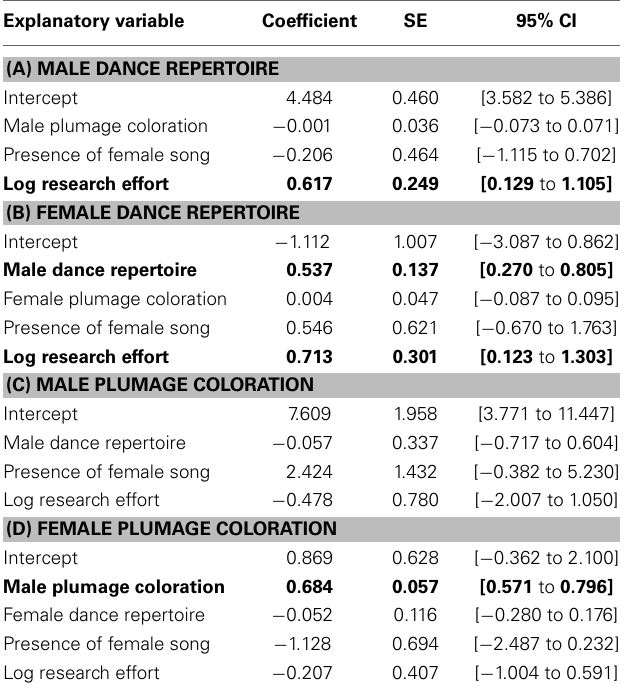
2011) and R package “phytools” (Revell, 2012). To compare